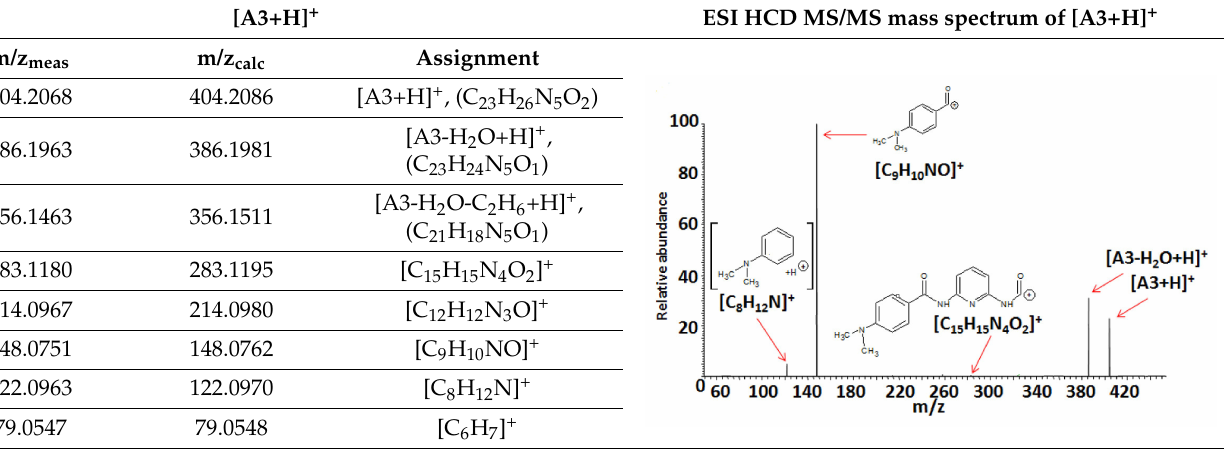
Table 6. Stability constants of the complexes of compounds A1–A3 with various metal ions.